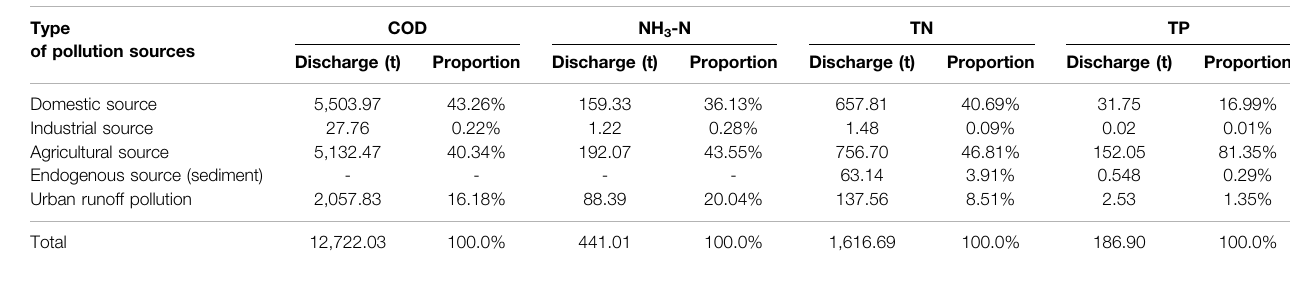
TABLE 5 | Discharge from pollution sources around the Zhangze